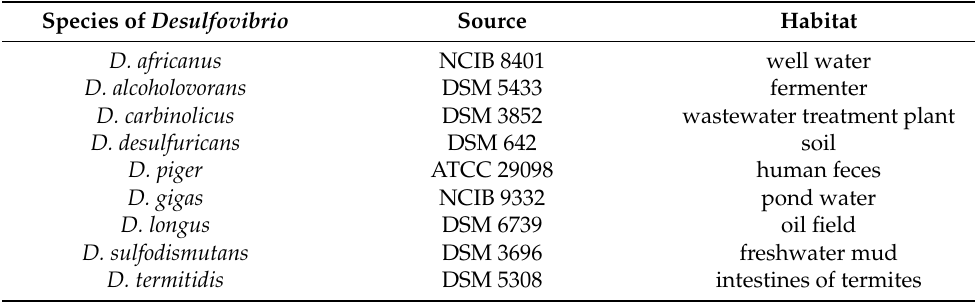
Table 1. Habitats of selected members of the genus Desulfovibrio (modified from Faque [10]). Species of Desulfovibrio